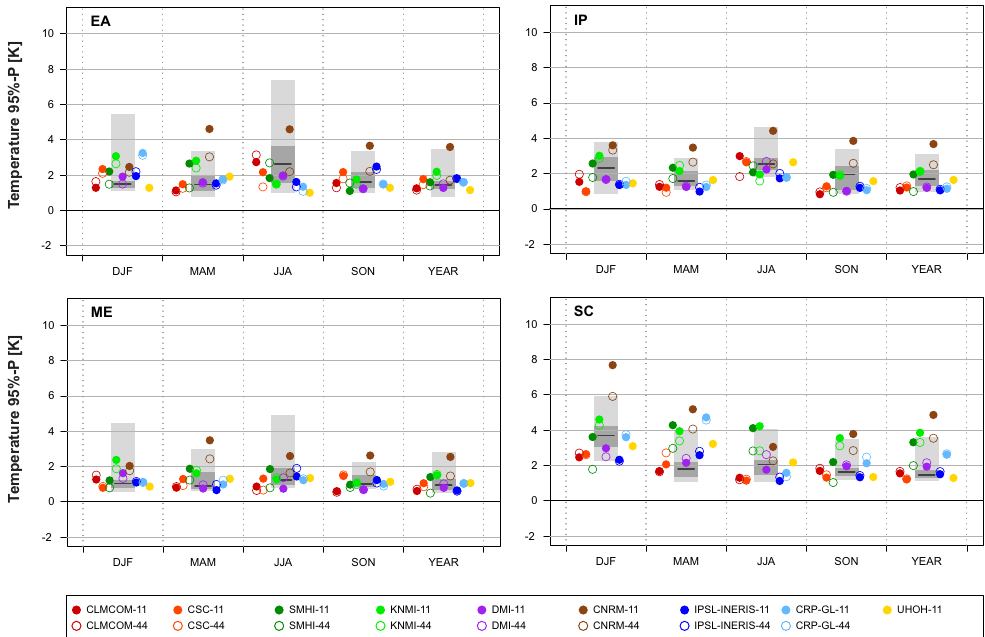
Figure 7. 95th percentile of mean seasonal and annual absolute temperature biases (95%-P; K) for the EUR-11 (filled circles) and the EUR- 44 ensemble (open circles) and for subdomains EA, IP, ME and SC (see Figure B3 for subdomains AL, BI, FR and MD). The gray bars denote the 95%-P range of the ENS-22 ensemble: entire range in light gray, interquartile range (corresponding to eight models) in dark gray and median as solid line.